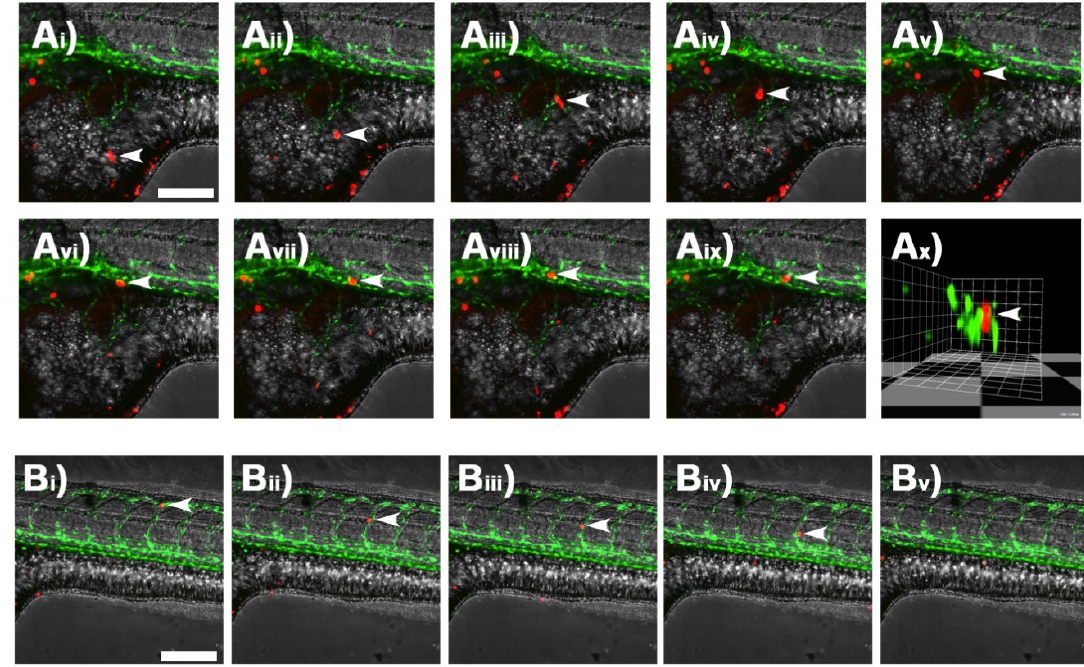
Figure 2. Single cell tracking by time-lapse confocal microscopy. Ai – ix ) Confocal z-stack images taken at 15 minute intervals showing an individual DiI-labelled A375 melanoma cell (white arrows) migrating within the yolk sac of a casper zebrafish embryo and interacting with a GFP-tagged blood vessel. Ax ) 3D-render of image Aix rotated to show the transverse section through the GFP-tagged blood vessel with DiI-labelled melanoma cell indicated by white arrows. Bi – v ) Confocal z-stack images taken at 15 minute intervals showing an individual DiI-labelled melanoma cell (white arrows) within the GFP-tagged blood vessels of a casper zebrafish embryo. Scale bar = 150